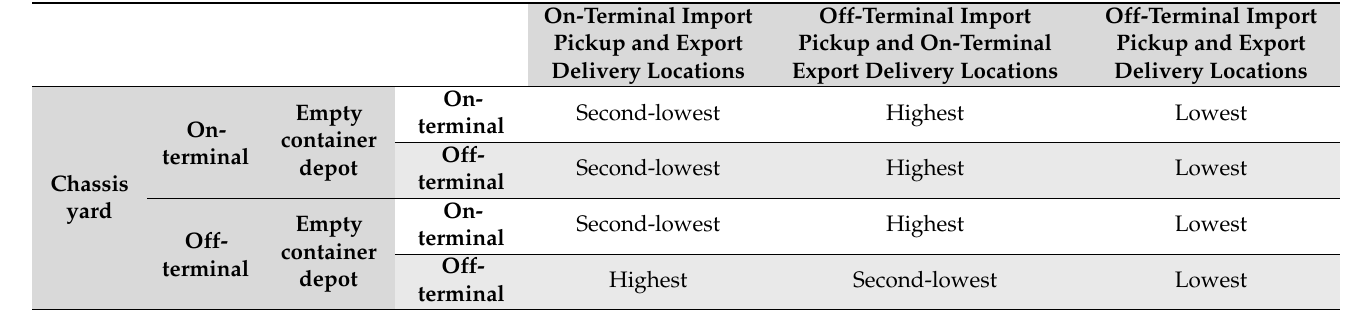
Table 5. The relative ranking of traditional and new practices in placing import pickup and export delivery locations (i.e., scenarios) based on drayage operation time where percent of job nodes is 25:25:25:25.